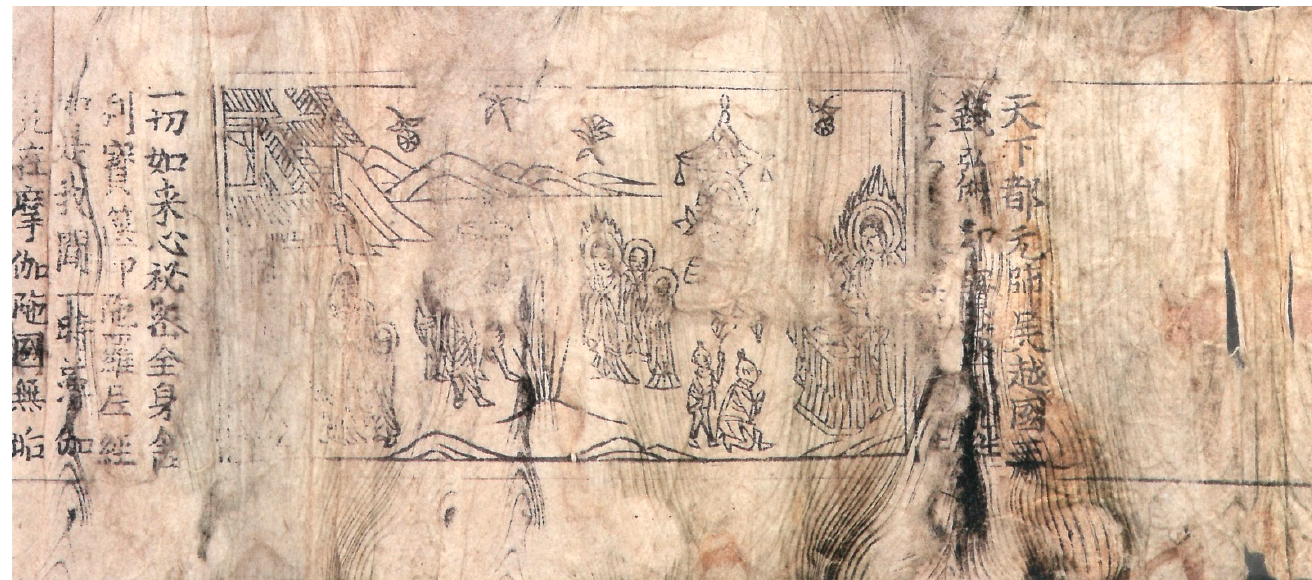
Figure 2. Detail of the Kara ṇḍ amudr ā S ū tra . Found in Wuwei County, Anhui Province, China. 956 CE, Wuyue (907–978). Xylograph; ink on paper. H. 7 cm; L. 150 cm. Anhui Provincial Museum. After (Li 2011, p. 156).